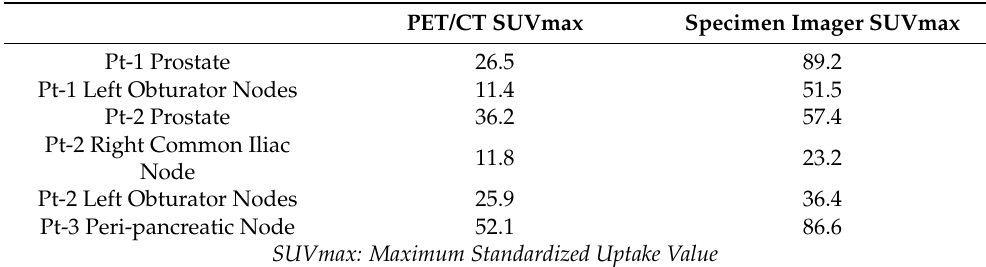
Table 1. Semi-quantitative data measured both in pre-operative whole-body PET/CT and high- resolution specimen PET/CT